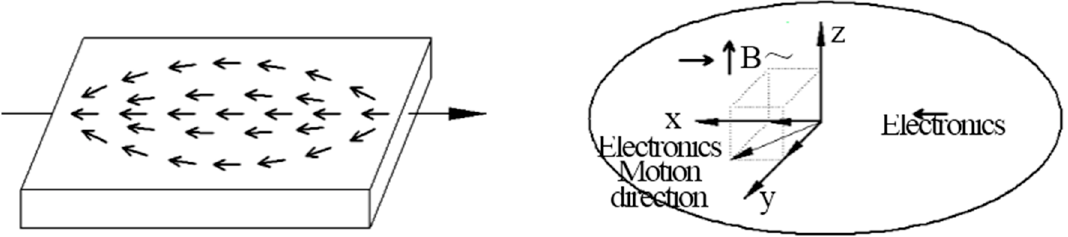
Figure 7. Schematic diagram of magnetic field on electron.